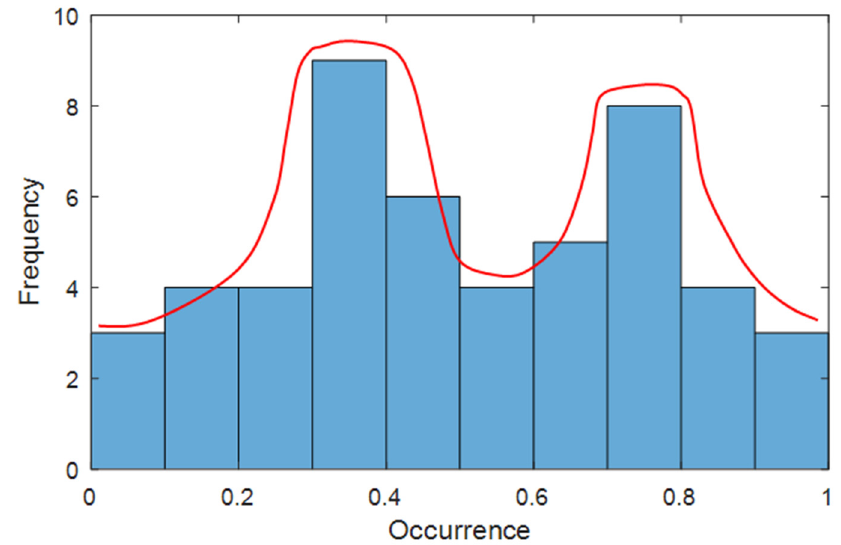
Figure 3. Example of histogram of a bimodal distribution.